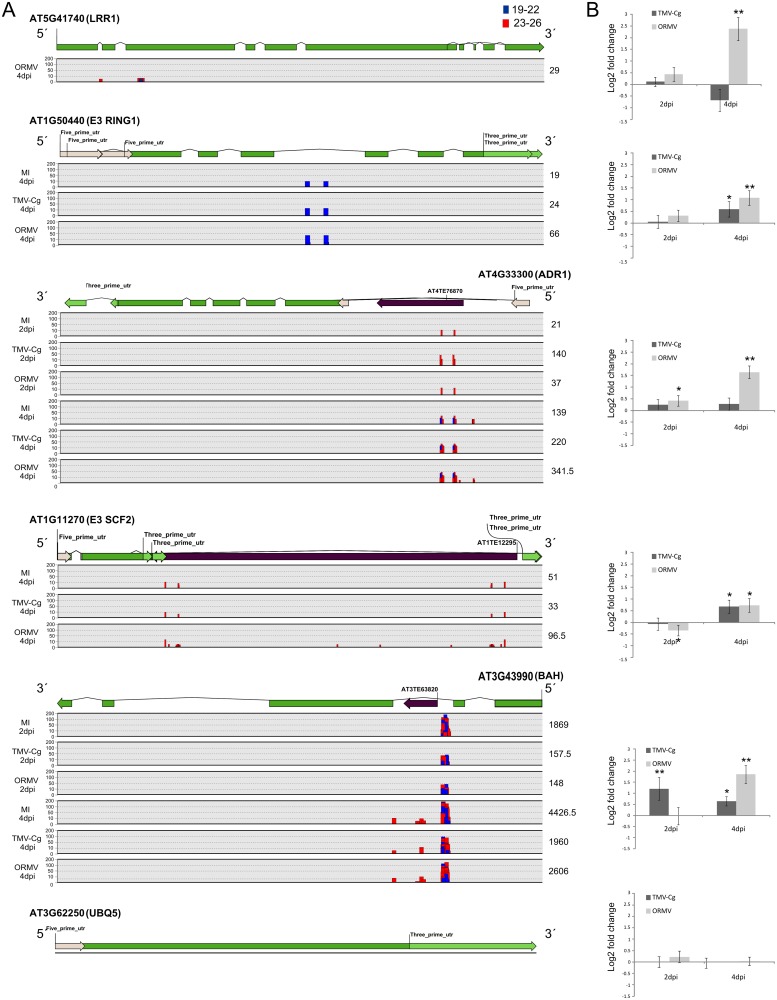
Selected genes with differential sRNA abundance.(A) Schematic representation of the position in which sRNAs mapped to the selected genes. Each bar represents the abundance and position of sRNAs mapped to the gene. Small RNAs of 19-22nt (blue bars) and 23-26nt (red bars) are represented. (B) qRT-PCR analysis of mRNAs of selected genes at 2 and 4dpi for TMV-Cg and ORMV-infected plants compared to mock inoculated. Log2 fold change of selected genes at 2 and 4dpi are shown. Errors bars represent SE. * = 0.01≤p≤0.05; ** = 0.001≤p≤0.01. AT5G41740 (LRR1) and AT4G33300 (ADR1) are members of LRRs families; AT1G50440 (E3 RING1) and AT1G11270 (E3 SCF2) are members of E3 ligases families. AT3G43990 (BAH) is a putative transcription regulator. UBQ5 gene was used as a negative control displaying no sRNAs associated and no differential transcript accumulation compared to EF1alpha housekeeping gene.